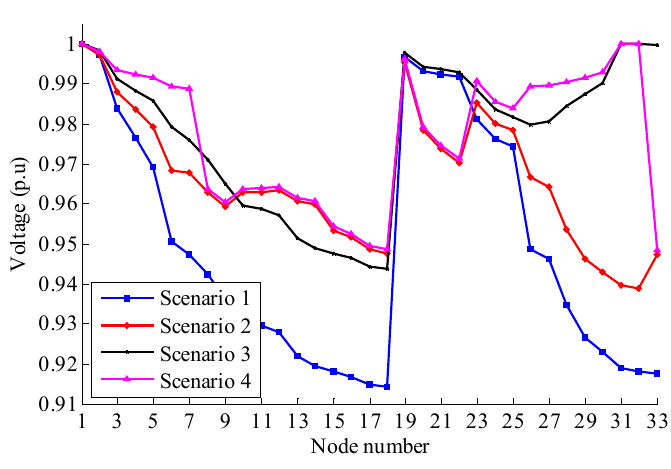
Figure 4. The topology of solution of Scenario IV.